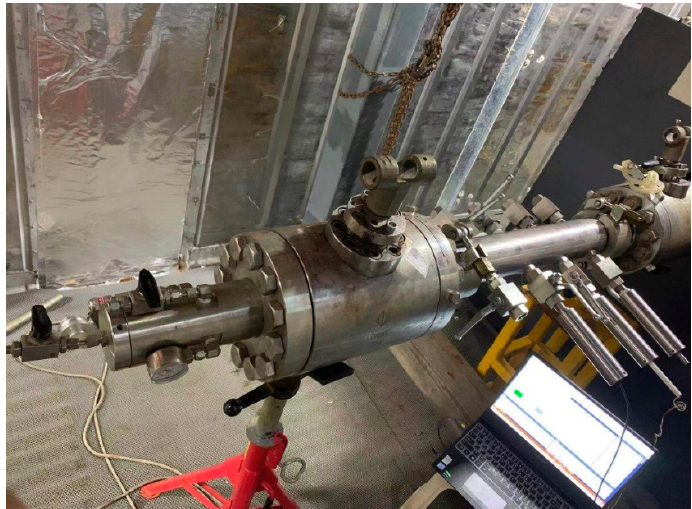
Figure 22. Field plot of pressure-maintaining transfer device for marine sediment resistivity meas- uring instrument.